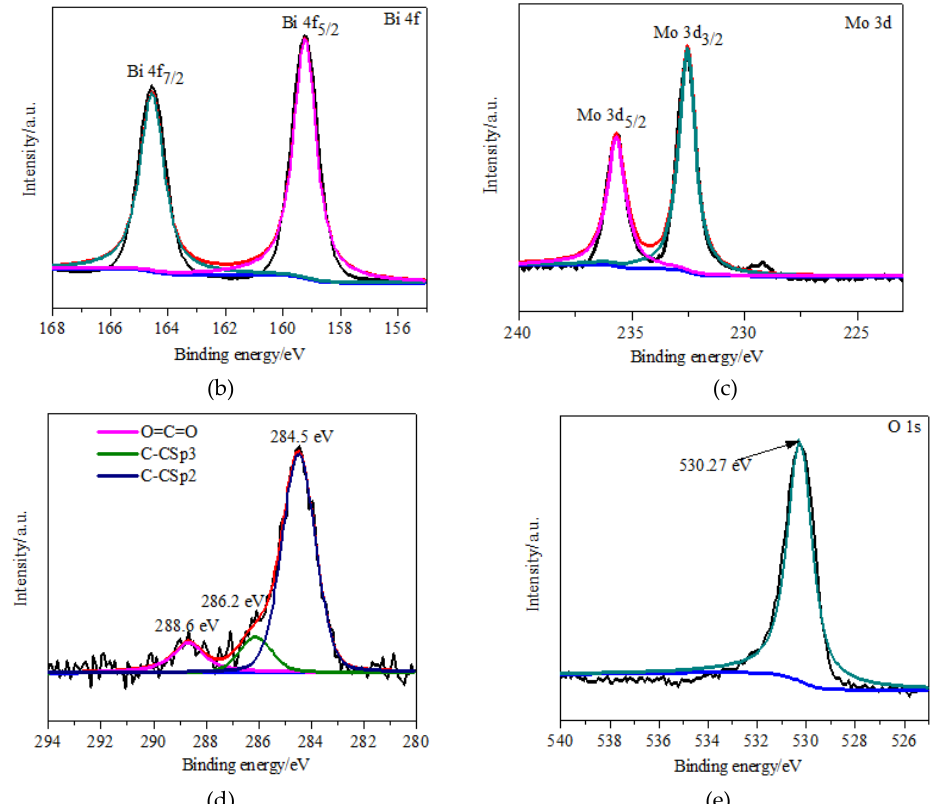
Figure 5. XPS spectra of the BMO/C sample: ( a ) survey, ( b ) Bi 4f, ( c ) Mo 3d, ( d ) C 1s, ( e ) O 1s.